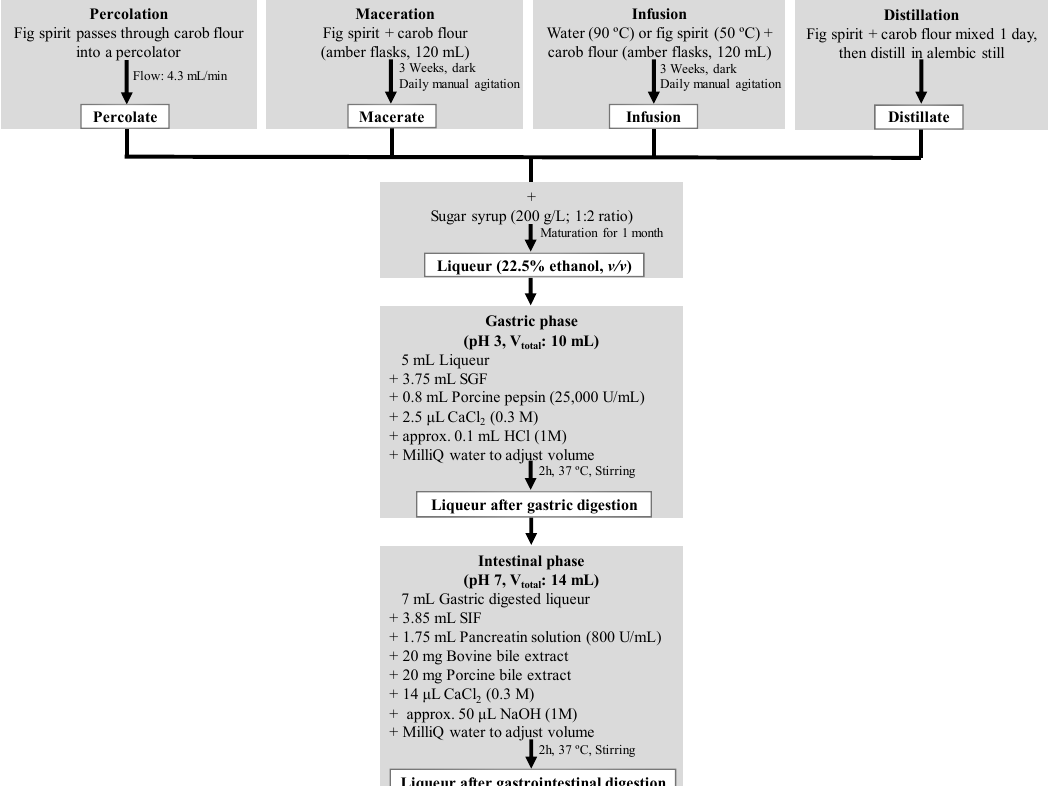
Figure 1. Schematic representation of the liqueur production, by different extraction methods, and the gastric and intestinal phases of the in vitro digestion process, with the respective constituents (such as simulated gastric (SGF) and intestinal (SIF) fluids) and conditions used.